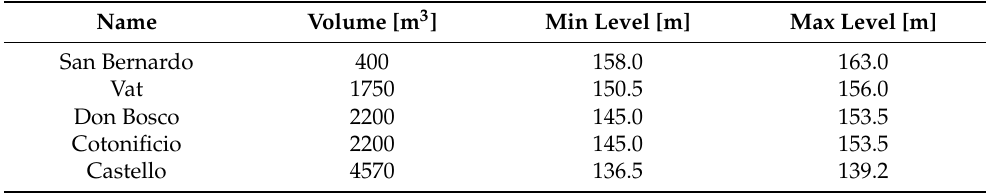
Table 1. Udine WDN tanks main characteristics.